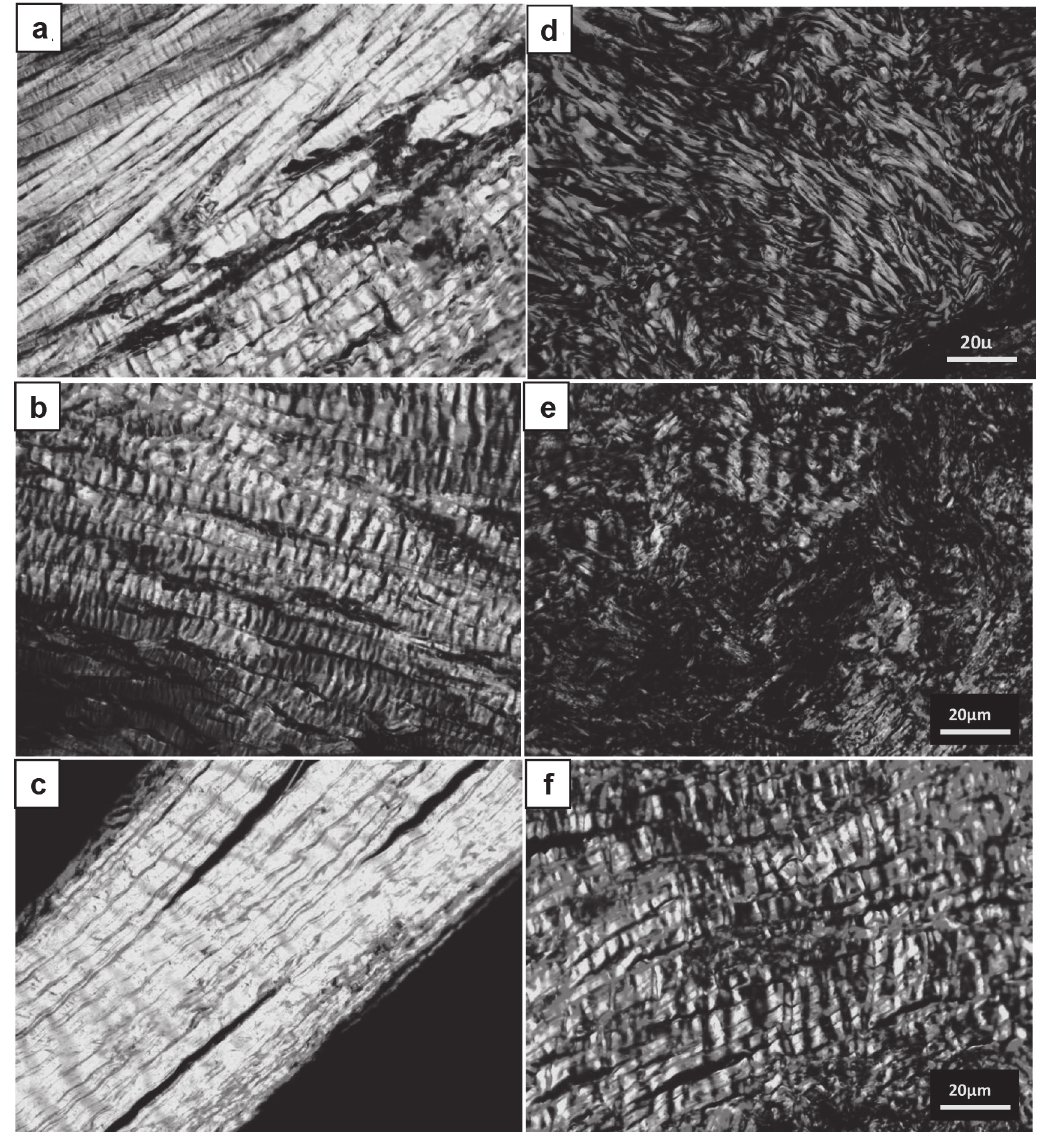
Figure 5 - Fotomicrographs of collagen fibers observed under polarized light microscopy. Type I collagen fibers: yellow, orange and reddish color; type III: green color. Organized collagen fibers were observed in the horns ( a and b ) and in the body ( c ) of the contralateral menisci (OM). In the treated menisci (TM), the fibers were found to be disorganized in the horns ( d and e ) and organized for the majority of the fibers present in the body ( f ). Picrosirius Red. (See the colors in the online